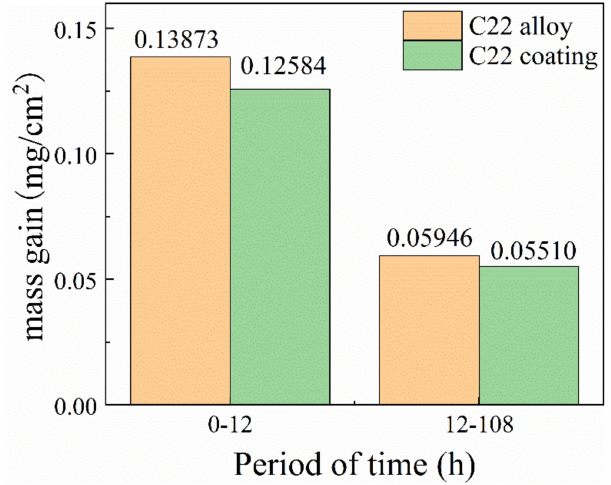
Figure 4. Comparison of corrosion mass gain between 0–12 h and 12–108 h of C22 alloy and C22 laser coating corroded in reducing atmosphere for 108 h at 450 ◦